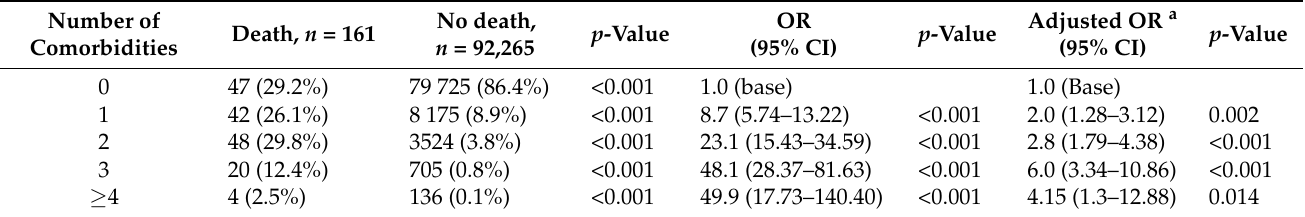
Table 3. Association between Number of comorbidities and COVID-19 mortality—Multivariable logistic